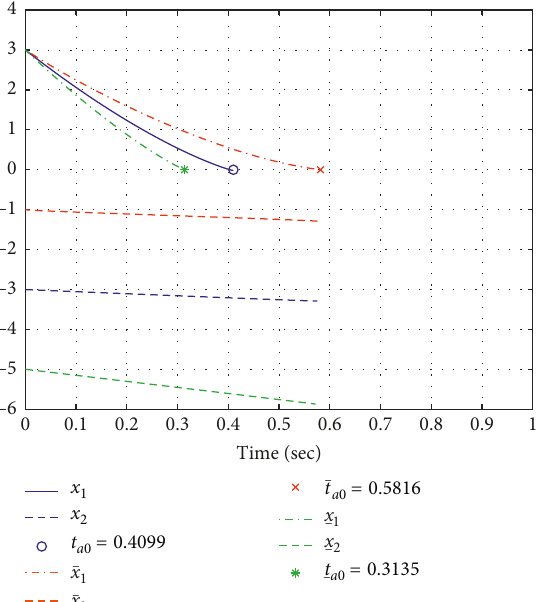
Figure 10: Finite-time convergence of the output with perturbation.